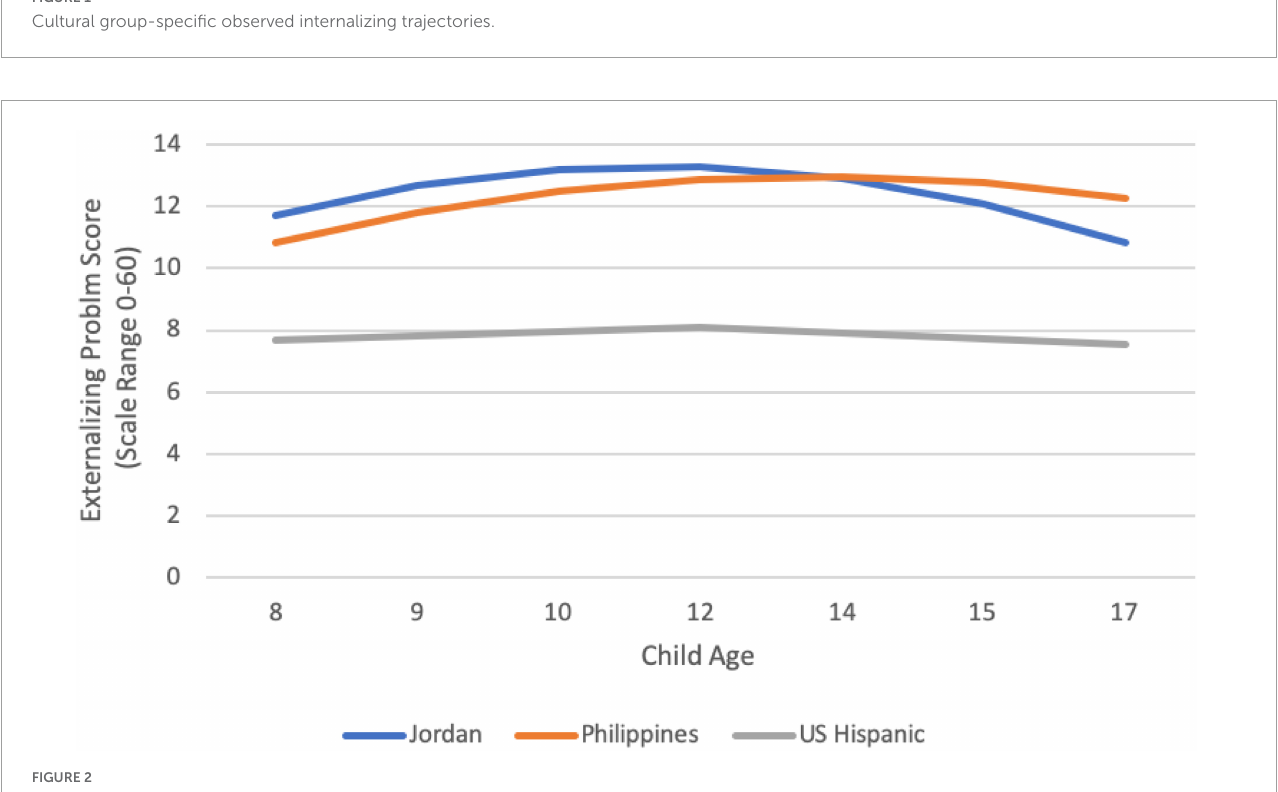
FIGURE1 Cultural group-specific observed internalizing trajectories.